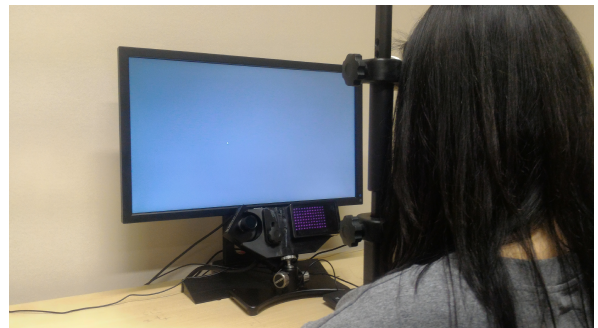
Figure 5 . Experimental setting featuring the SR Re- search EyeLink 1000 eye tracker and chin rest.